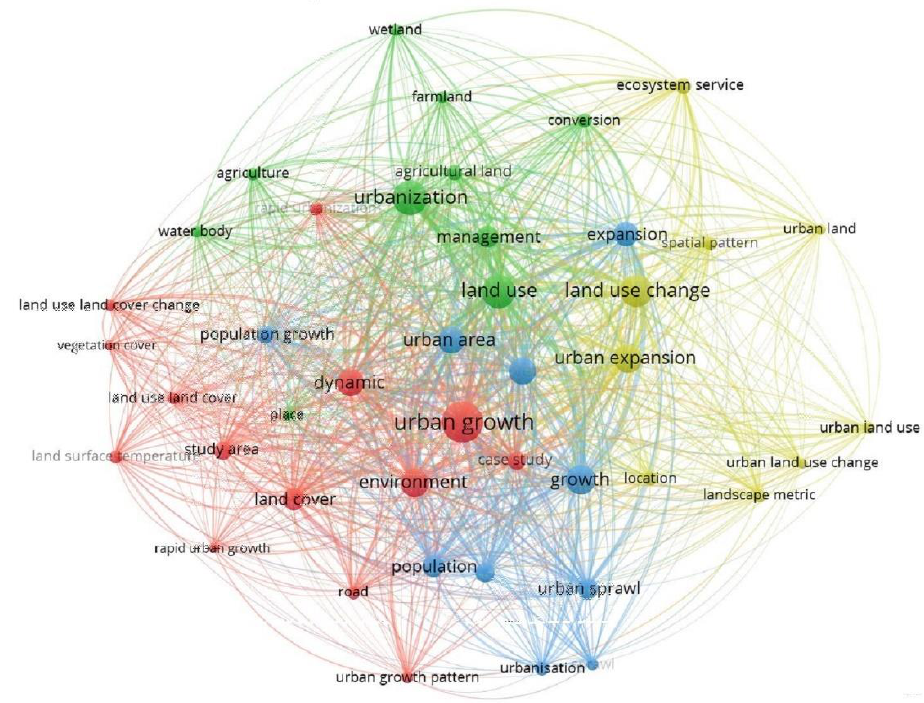
Figure 3. Primary codes (factors driving LULCC) found in the 451 selected records by